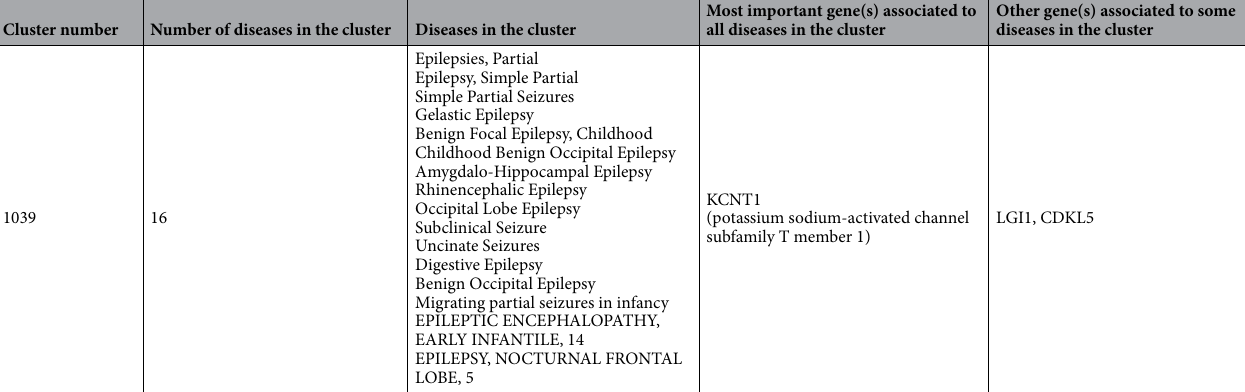
Table 4. Relevant information of the largest clusters formed in the first analysed model obtained performing OPTICS. Only the 9 first largest clusters are shown. The number of diseases, the names of such diseases inside each cluster and the genes related to those diseases are included in the table. The most important gene(s) column depicts the gene(s) that is/are associated to all the diseases in the cluster. The last column presents other genes that are related to multiple diseases in the